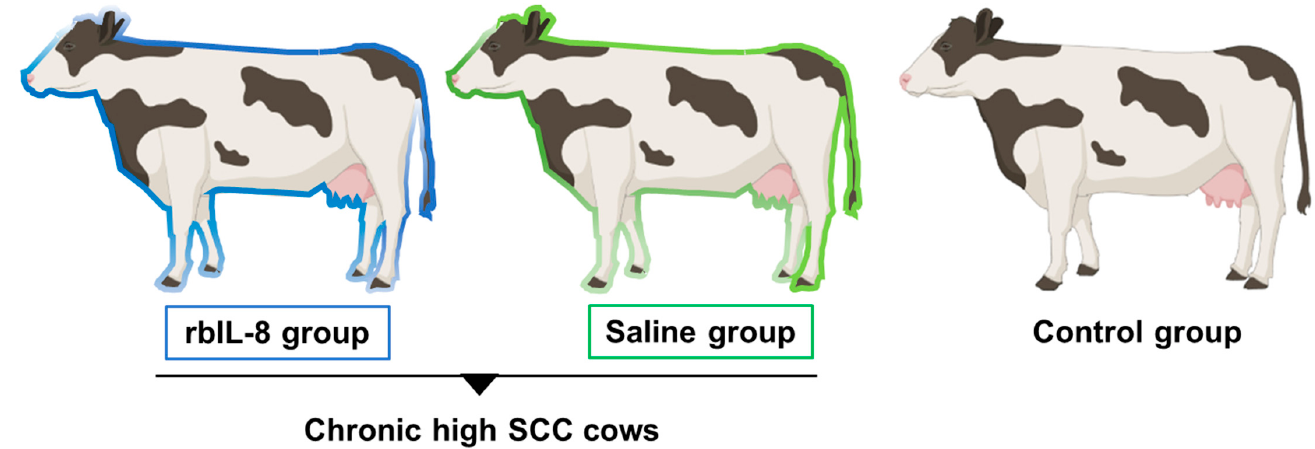
Figure 1. Visual representation of the cows presenting chronic high SCC and the low SCC cows (control). The chronic cows were submitted to one of two intramammary treatments, rbIL-8 (blue outline) or saline (green outline), whereas the control group remained untreated (no outlines). The chronic high SCC cows were randomized based on the quarter that presented the highest SCC, and only the respective quarter received the intramammary infusion. Both rbIL-8 and saline groups had a similar SCC at 0 h relative to treatment (rbIL-8: SCC = 3259 ± 1625 × 10 3 cells/ml; and saline: SCC = 2657 ± 1625 × 10 3 cells/ml, p = 0.519).